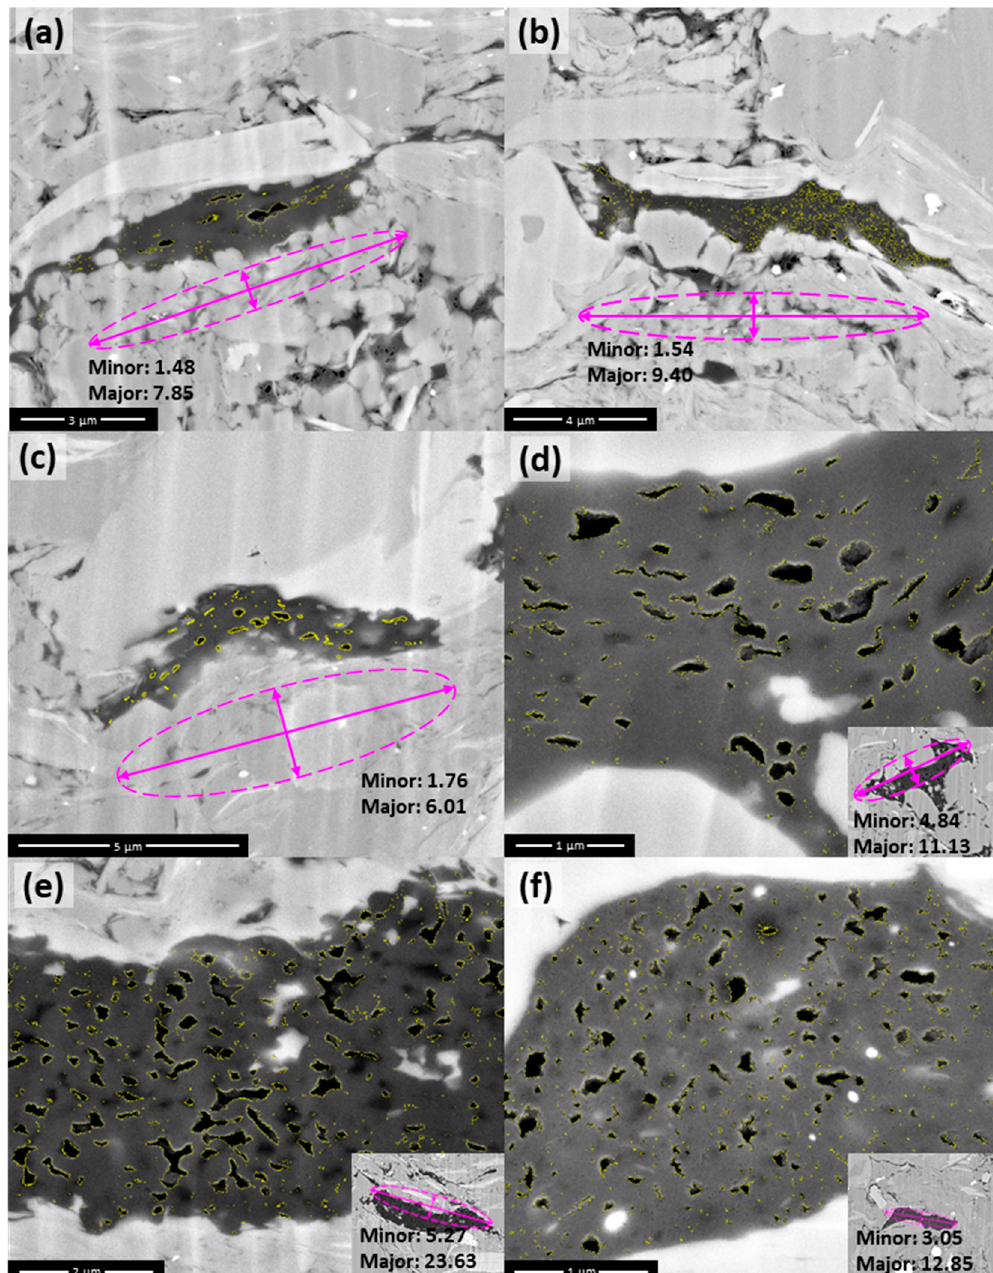
Figure 10. The typical examples of the first subtype of moderately to strongly deformed pyrobitumen (OM IV) from Longmaxi-Wufeng Shale, Sichuan Basin. ( a ) SEM image JY1S-9-25 (well ID-sample no.-image no.); ( b ) SEM image JY1S-15-31; ( c ) SEM image JY8S-3-35; ( d ) SEM image JY8S-5-20; ( e ) SEM image JY8S-5-39; ( f ) SEM image JY8S-5-17. The boundary of OM-hosted pores was outlined by yellow lines; the purple ellipse is the area-equivalent ellipse of OM; the unit of major and minor axis is µm.